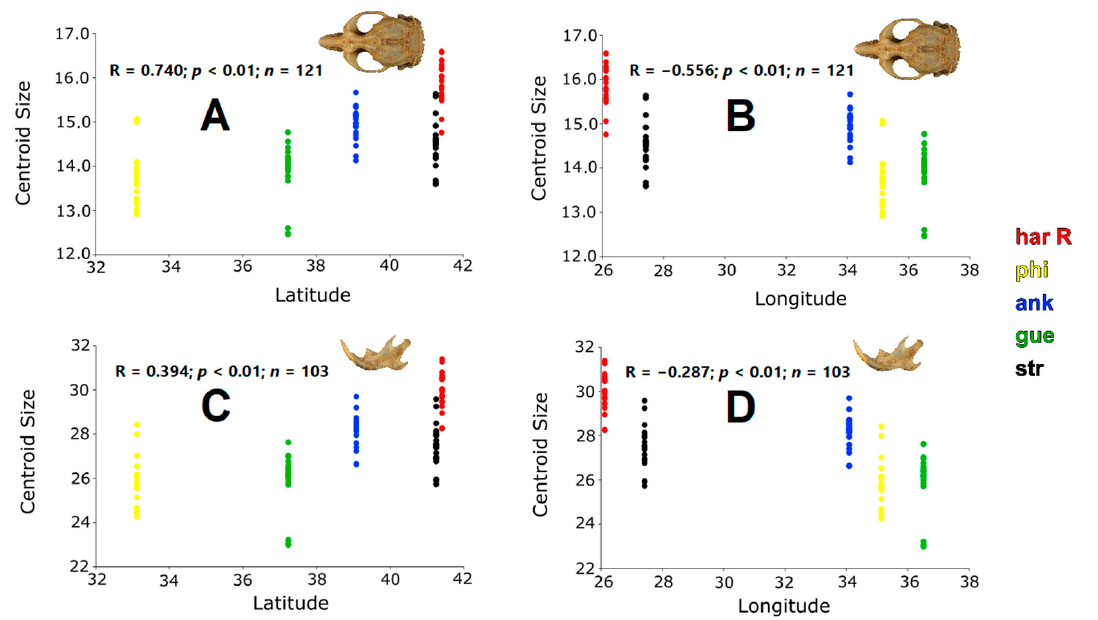
Figure 7. Correlations between centroid size–related cranial GM landmark data ( A , B ) or mandibular GM landmark data ( C , D ) and the geographical latitude and longitude of sampling.